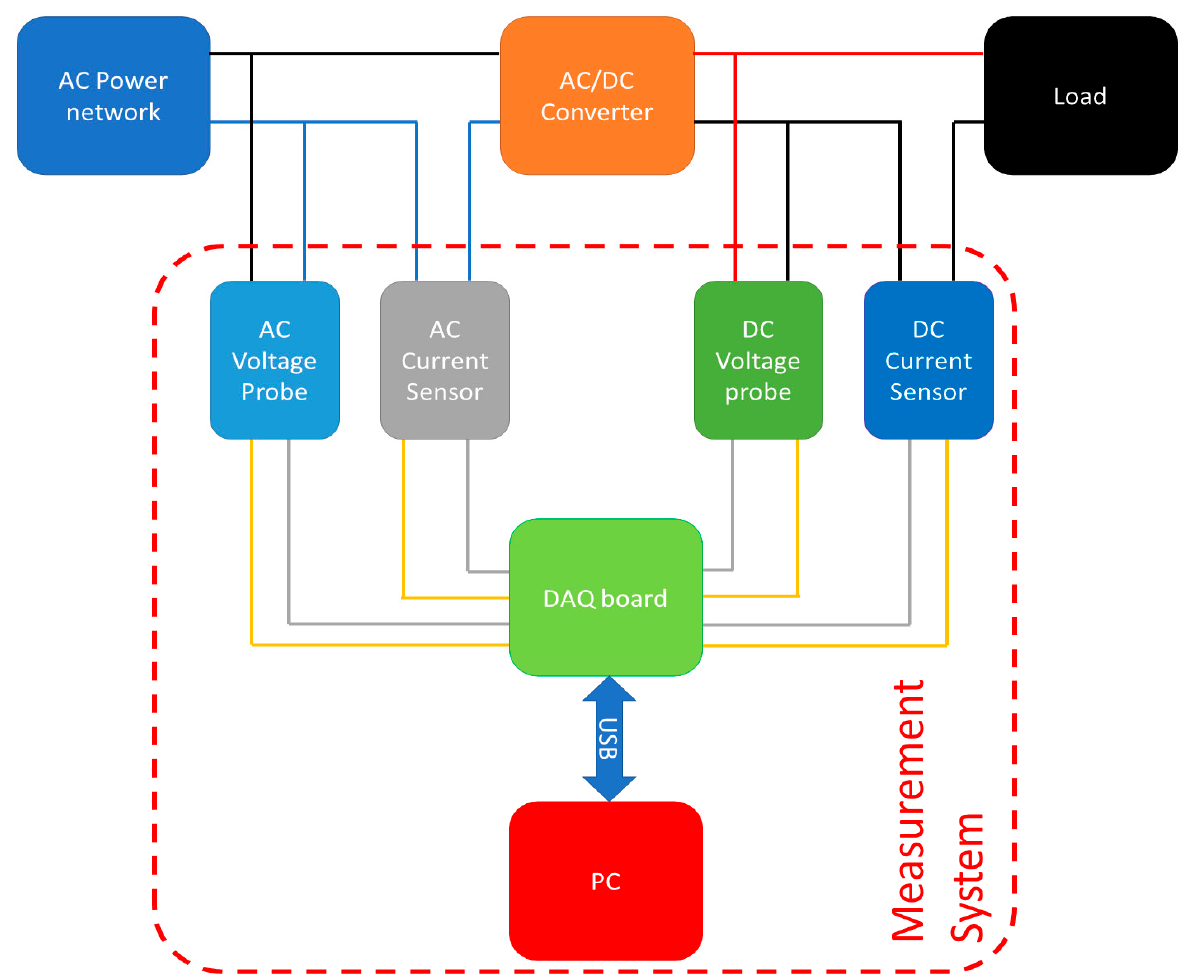
Figure 3. Simplified block diagram of the measurement system.